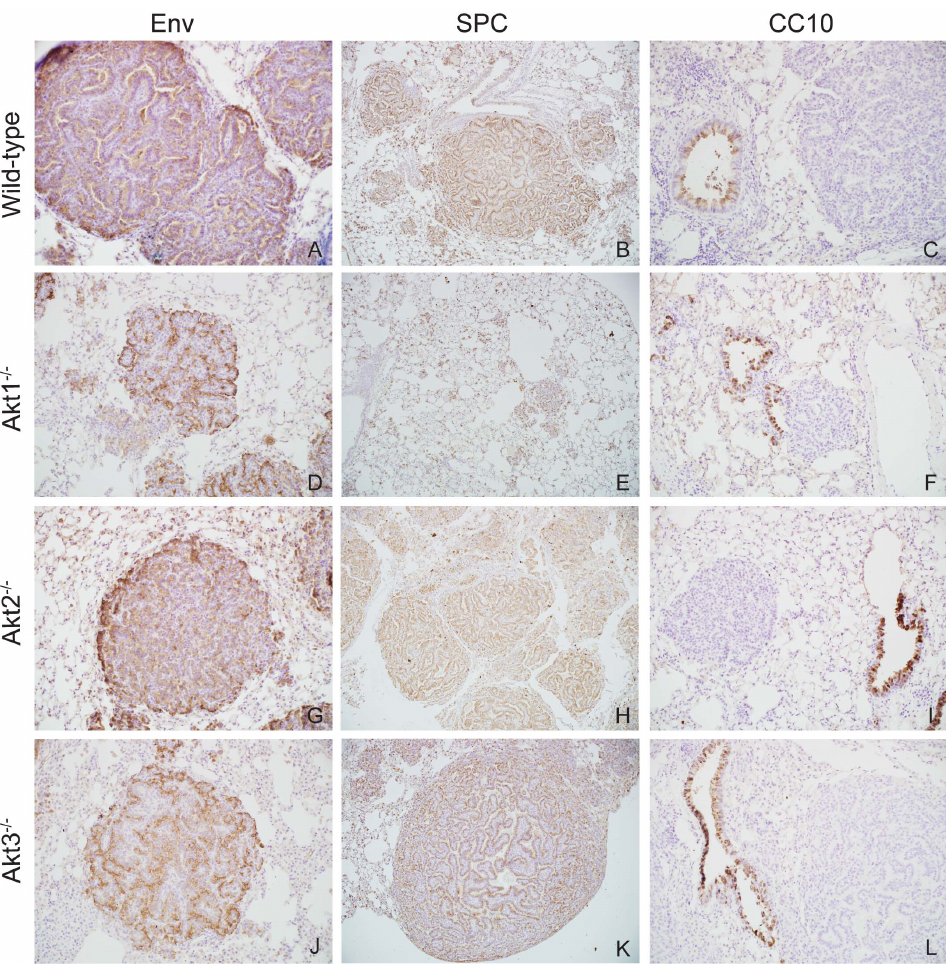
Figure 4. Lung tumors uniformly express Jenv and SPC irrespective of Akt isoform status. Immunostaining for Jenv, SPC, and CC10 expression in lung tissue from A JE JJenv infected WT (A to C), Akt1 2 / 2 (D to F), Akt2 2 / 2 (G to I), and Akt3 2 / 2 (J to L) mice at 10 6 magnification. Representative images of advanced neoplastic lesions show robust Jenv expression within all cells of the lung tumor (A, D, G, J). Representative images show lung tumors staining uniformly positive for SPC (B, E, H, K) and negative for CC10 (C, F, I, L).